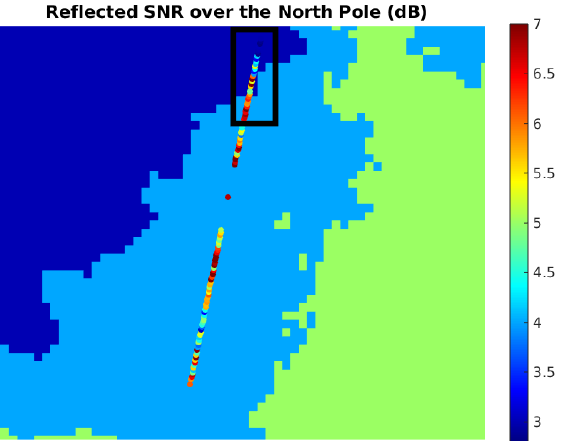
Figure 13. Geo-referenced SNR (dB) for a single FMPL-2 GNSS-R track, overlaid with OSISAF SIE product. Dark-blue is open water, light blue is open ice (concentration between 30% and 70%), and green is closed ice. Note that, the color contrast has been adjusted to ease its visualization.